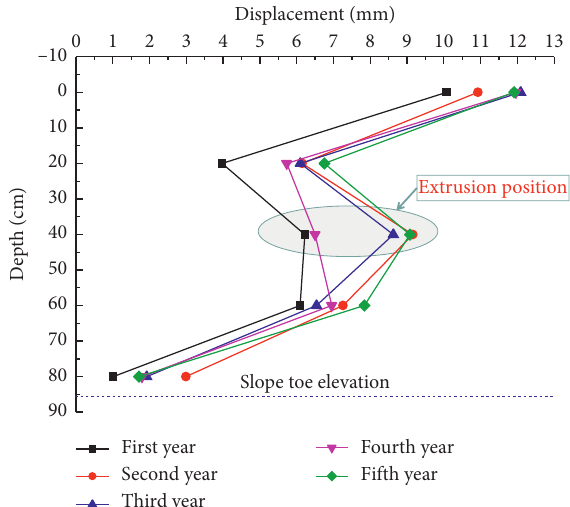
Figure 16: Variations of horizontal displacements with depth at the end of the five years.